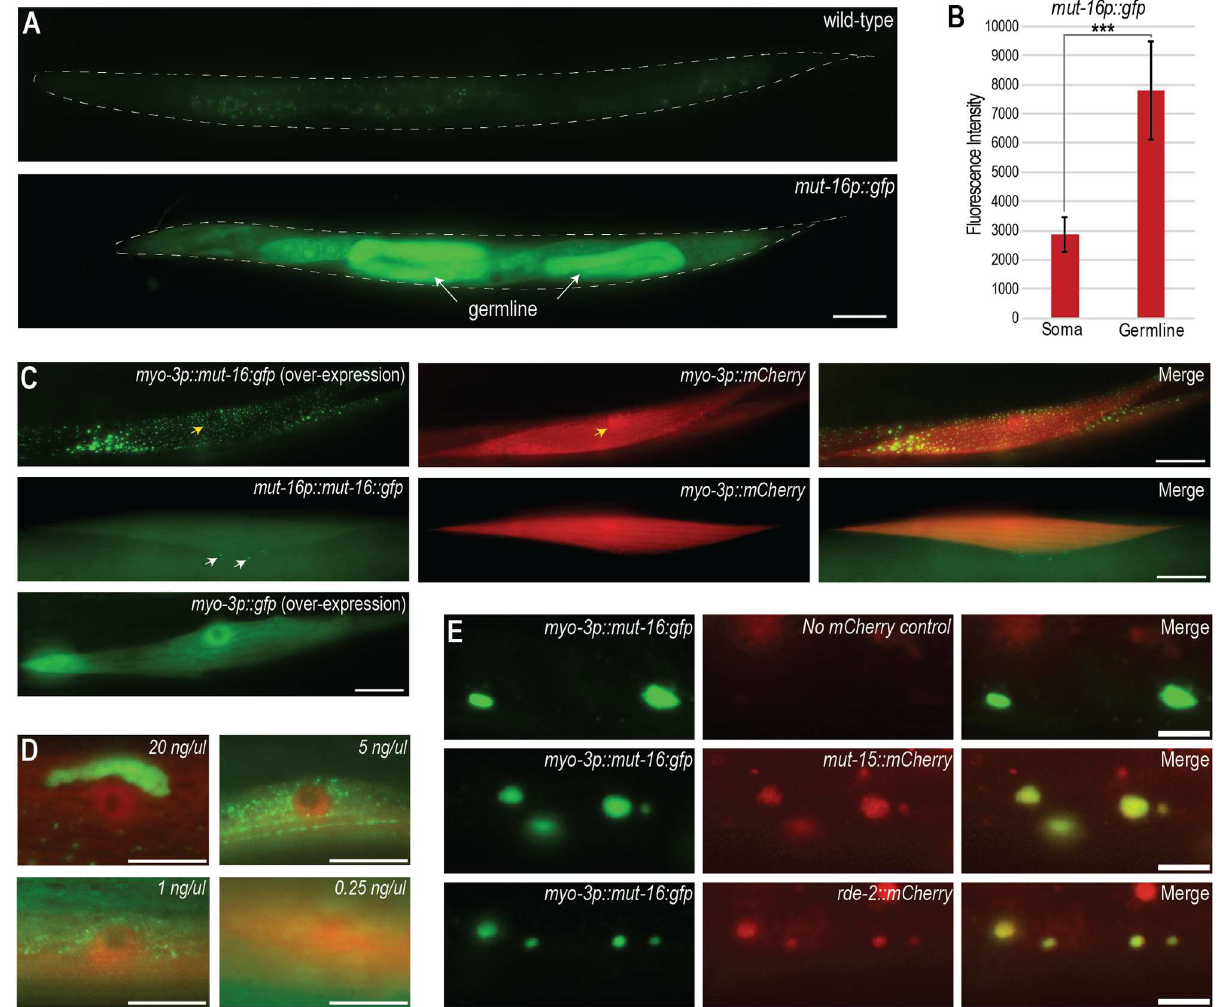
Fig 6. Concentration dependence of Mutator foci. (A) GFP expression in negative control (wild-type) and mut-16p :: gfp L4 stage animals. The same exposure time was used for both images. Scale bar, 50 μ m. (B) Quantification of GFP fluorescence in the soma and the germline of mut-16p :: gfp animals. Fluorescence intensity was calculated using ImageJ by tracing the germline and soma of 31 L4 stage animals and measuring the mean gray value. P values were calculated using a paired t-test ( (cid:3)(cid:3)(cid:3) indicates p < 0.001). (C) Top row: MUT-16::GFP overexpressed from the myo-3 promoter forms foci in muscle cells marked with muscle-specific mCherry. Yellow arrow indicates the location of the nucleus. Middle row: Endogenously expressed MUT-16:: GFP in muscle cells marked with muscle-specific mCherry does not form foci. White arrows point to MUT-16 foci in the neighboring germ cells. Bottom row: Overexpression of the GFP protein alone in muscle cells does not form foci. Scale bars, 10μm. (D) MUT-16::GFP in muscle cells labeled with myo-3 :: mCherry ,where myo-3p :: mut-16 :: gfp was injected at the indicated concentrations. Microscope exposure settings were changed as follows to account for variation in brightness between lines—top left: 0.02 sec exposure with neutral density filter at 10% transmittance; top right: 0.2 sec exposure; bottom left: 0.2 sec exposure; bottom right: 0.4 sec exposure. Scale bars, 10μm. (E) Top row: MUT-16::GFP overexpressed from the myo-3 promoter forms foci. No mCherry proteins are expressed in this strain. Middle and bottom rows: Overexpression of MUT-16::GFP in muscle cells recruits MUT- 15::mCherry (middle row) and RDE-2::mCherry (bottom row). Scale bars, 5μm.